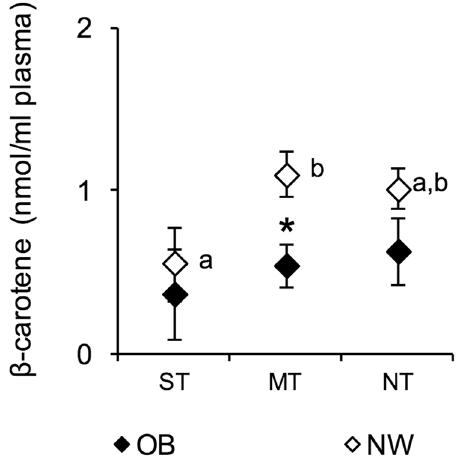
Figure 4. Mean values ± SEM of the plasma levels of beta-carotene measured in supertaster ( N = 9), medium taster ( N = 28) and non-taster ( N = 23) participants with normal weight (NW) and supertaster ( N = 12), medium taster ( N = 25) and non-taster ( N = 13) participants with obesity (OB). ST, supertaster participants; MT, medium taster participants; and NT, non-taster participants. The different letters indicate significant differences ( P = 0.0409; Newman-Keuls test subsequent to the two-way ANOVA). * A significant difference between participants with normal weight or with obesity ( P = 0.0044; Newman-Keuls test subsequent to the two-way